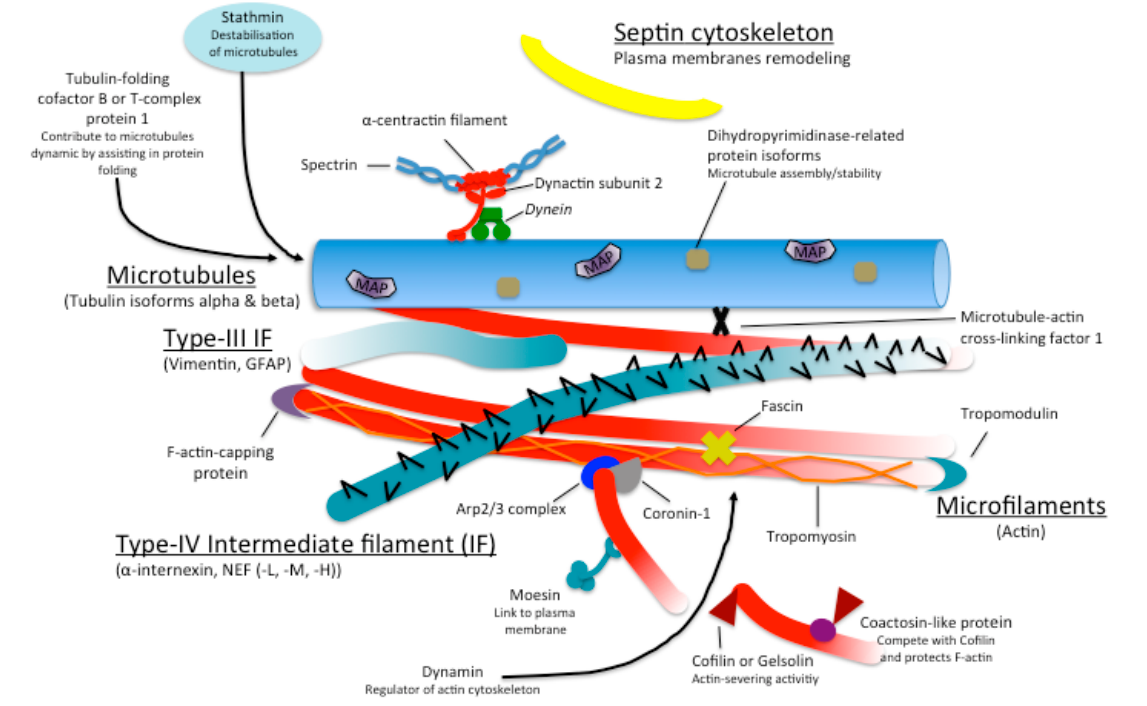
Figure 1. Illustrate the function/association of the differentially expressed cytoskeletal proteins in schizophrenic patients. This diagram has been updated from [18].